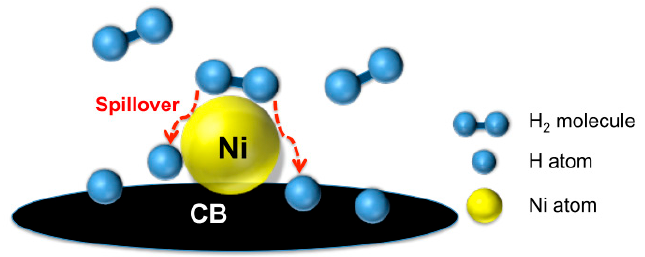
Figure 17. Proposed mechanism for hydrogen spillover on Ni/CB catalyst [93] .